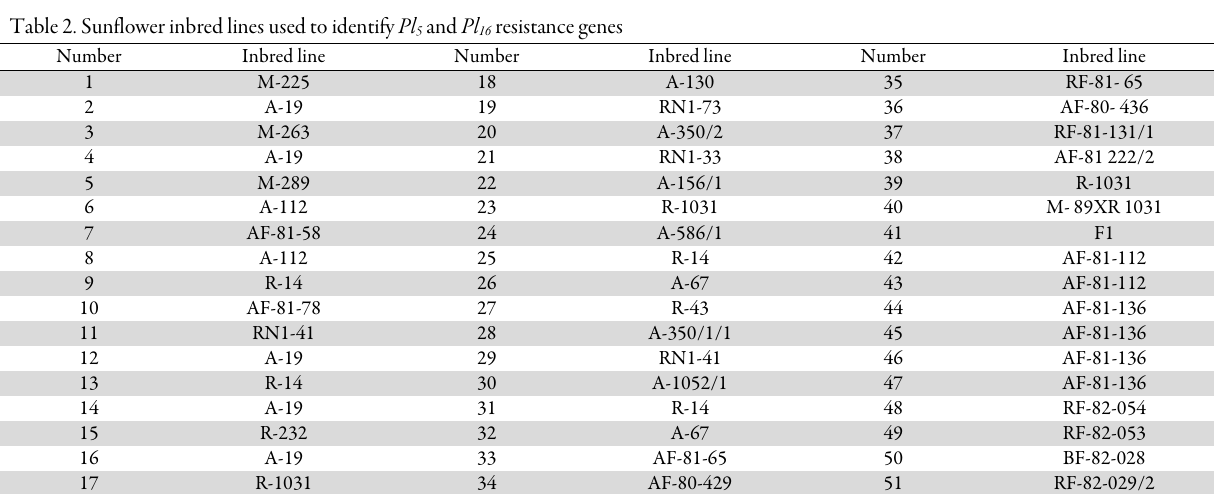
Table 2. Sunflower inbred lines used to identify Pl 5 and Pl 16 resistance genes Number Inbred line Number Inbred line